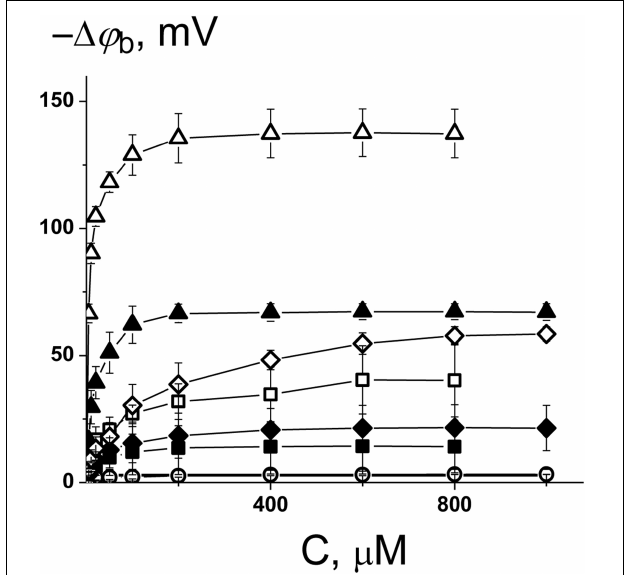
FIGURE 1 | Dependence of the decrease in the boundary potential of the membrane (– (cid:49) ϕ b ) on the concentration of C1 ( (cid:4) ), C2 ( (cid:3) ), C3 ( • ), C4 ( ( (cid:78) ), C6 ( (cid:49) ), C7 ( (cid:7) ), and C8 ( ♦ ). The membranes were composed of DPhPC and bathed in 0.1 M KCl at pH 7.4. V = 50